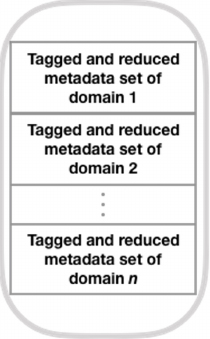
Figure 6. Statistical signature dataset (adapted from Brena et al.